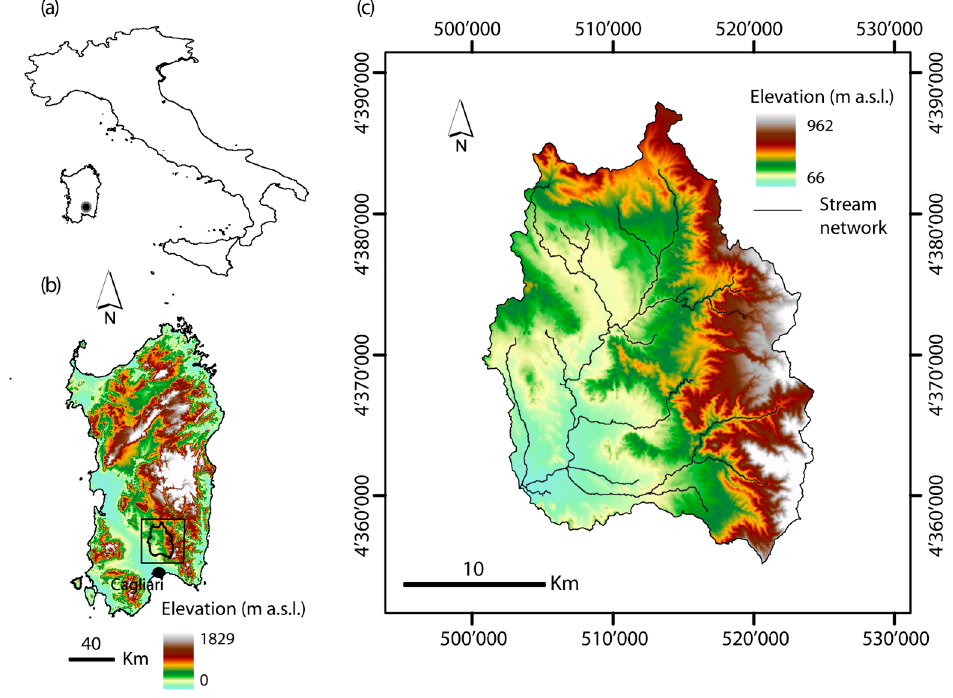
Figure 1. Location of the Rio Mannu basin within ( a ) Italy and ( b ) Sardinia. ( c ) Boundaries (in WGS84 UTM coordinates) and elevation and stream network of the basin (adapted from Perra et al. [31]).